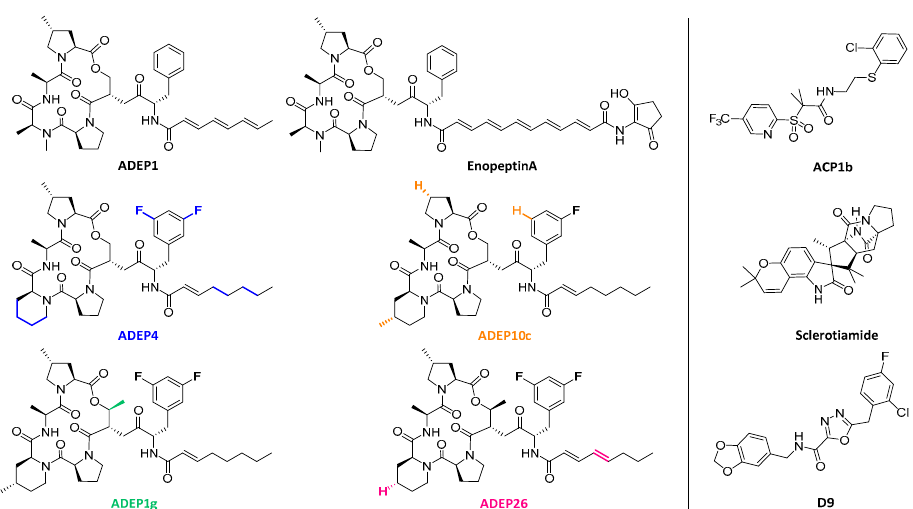
Figure 5. Chemical structures of ClpP activators. On the left, chemical structures of the mentioned ADEPs are shown. In the color matching their name, consecutive modifications respect to the previous ADEP are highlighted: the original ADEP1 and EnopeptinA (black), ADEP4 (blue), ADEP10c (orange), ADEP1g (green) and ADEP26 (pink). On the right side, alternative cores extracted from screening including ACP1b, Sclerotiamide and D9.